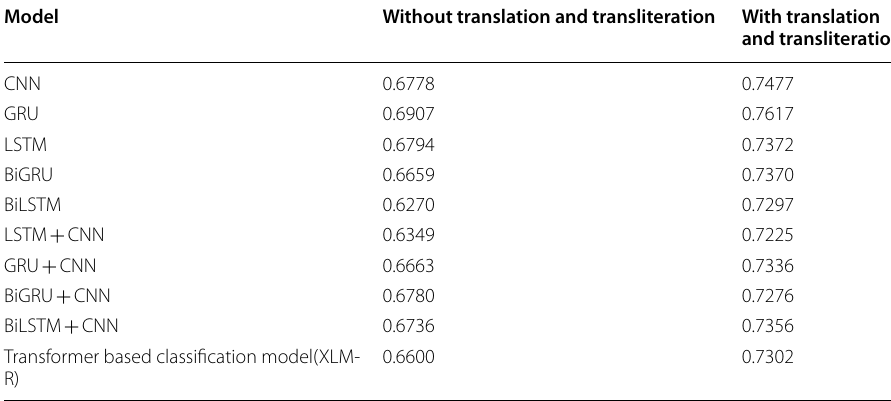
Table 11 F1-score comparison to show the effect of translation and transliteration for sentiment